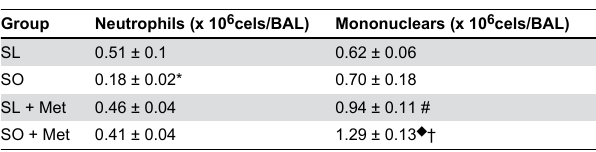
Table 1. Number of neutrophils and mononuclear cells in bronchoalveolar lavage (BAL) fluid at 48 h following intranasal challenge with ovalbumin in sensitized mice, treated or not with metformin (300 mg/kg/day, two weeks).